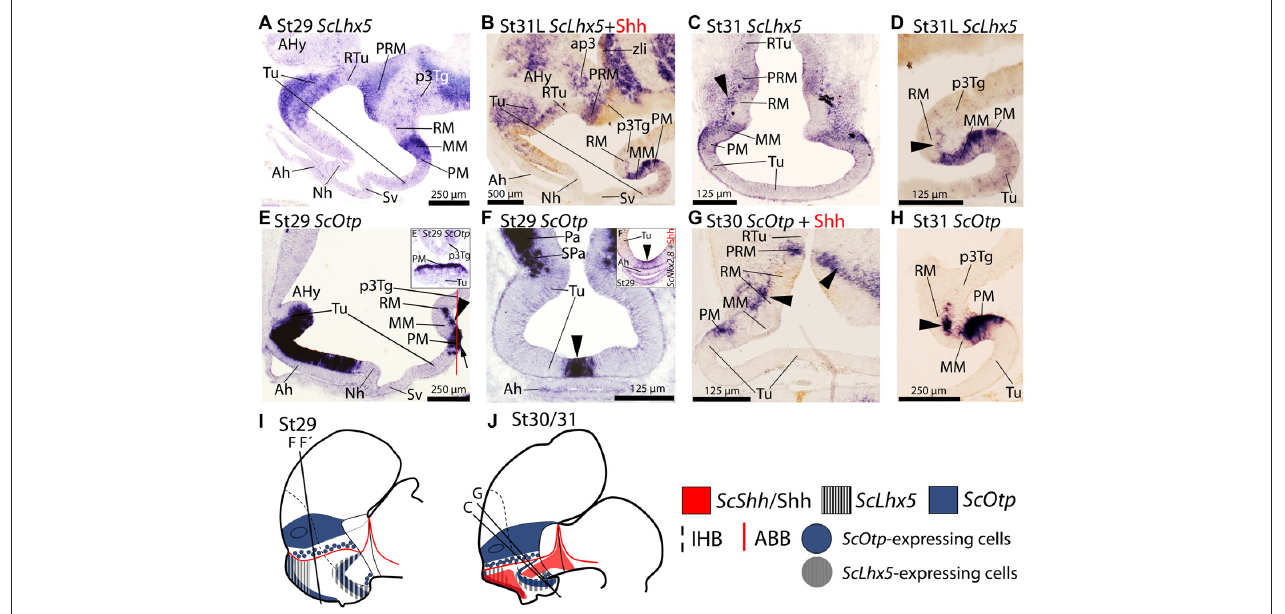
FIGURE 2 | Regionalization of the basal hypothalamus and neighbor territories in embryos of S. canicula at stages 29–31. Sections showing expression of ScLhx5 (A–D) ScOtp (E–H) by means of in situ hybridization (A–H) on sagittal (A,B,D,E,H) or transverse (C,F,G) sections. (I,J) Sagittal schemes to show expression patterns of ScShh /Shh, ScLhx5 and ScOtp at stage 29 (I) and stage 30/31 (J) . For simplicity, the schemes do not represent medial (acroterminal) expression patterns. Some in situ sections were double labeled for IHC against Shh (B,G) . (A–D) ScLhx5 expression in the Tu, PM/PRM and MM domains. Arrowhead in (C) points ScLhx5 -expressing cells in the mantle of the RM domain. Arrowhead in (D) shows a sharp limit abutting RM. Note that dispersed ScLhx5 expressing cells in the caudal and ventral-most part of Tu are not represented in (I,J) . (E–H) ScOtp expression in regions of the Tu and PM/PRM domains. Inset (E (cid:48) ) shows a transverse section at the level indicated by the red line in (E) . Arrowhead in (F) points the restricted ScOtp expression in the midline of the acroterminal region. Arrowhead in (F (cid:48) ) points ScNkx2.8 expression. Arrowheads in (E,G,H) indicate ScOtp -expressing cells in the mantle of the RM region lacking Shh immunoreactivity. For abbreviations, see